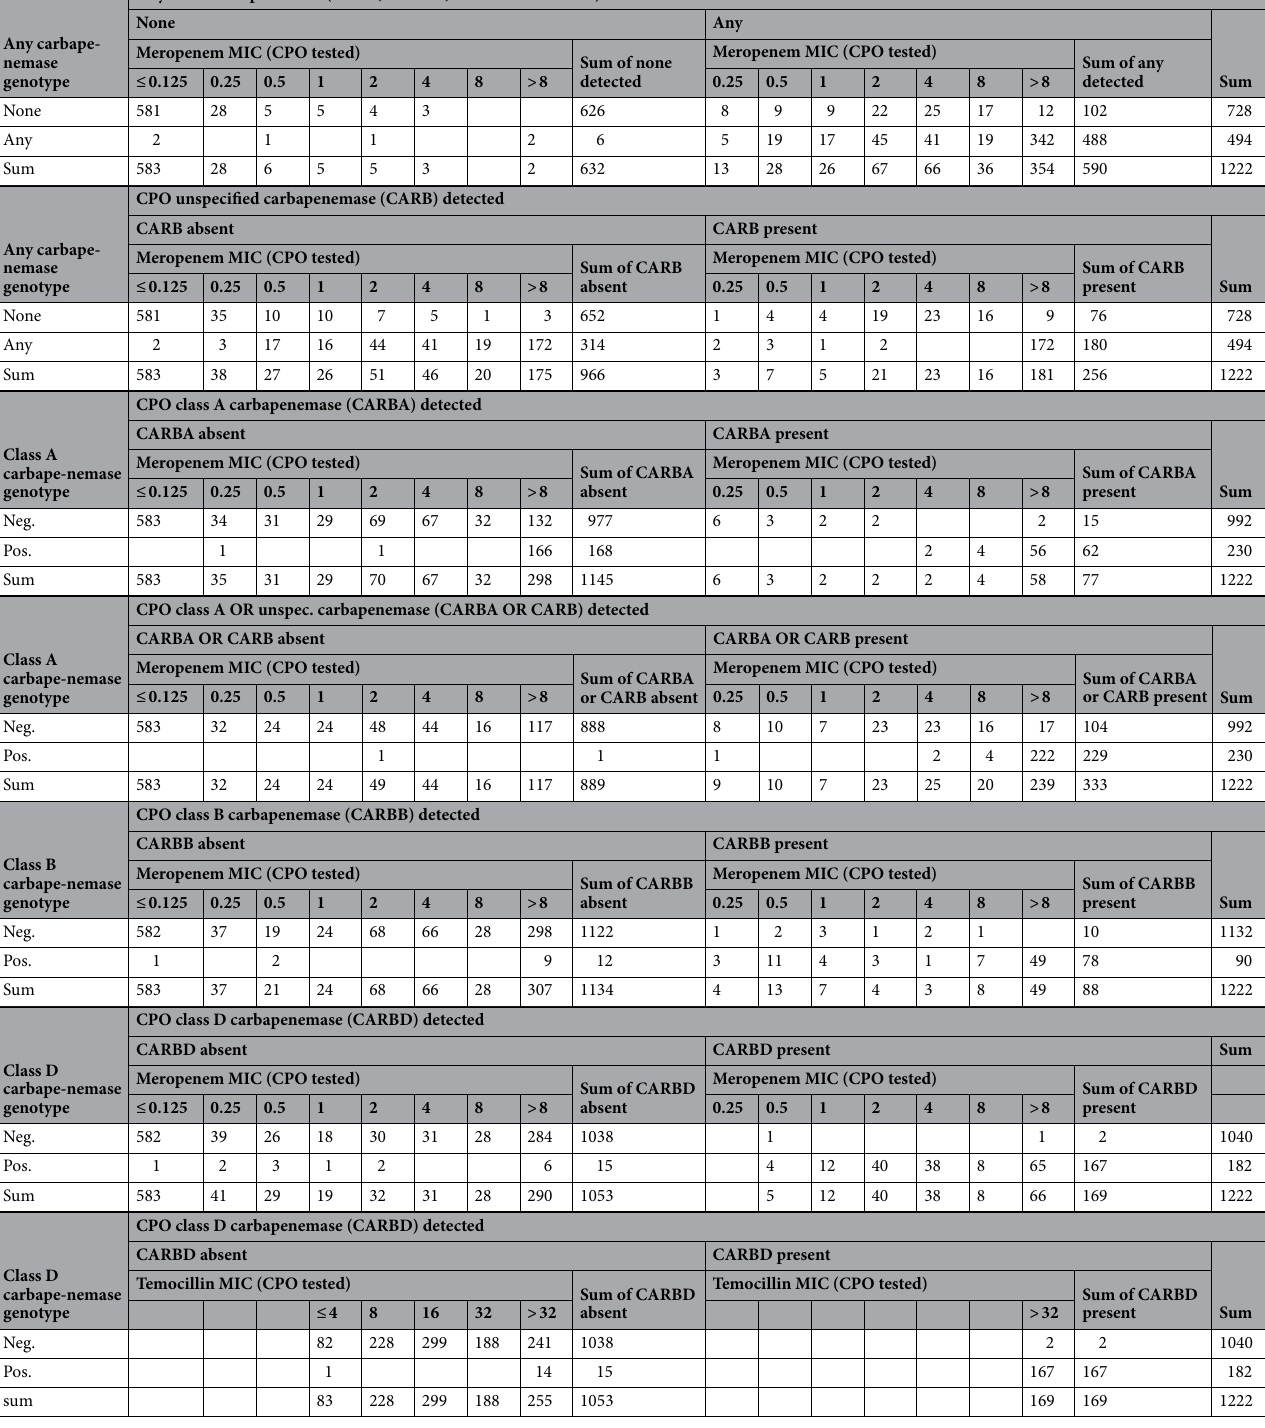
Table 2. MIC distribution and CPO panel detection of (un-)classified carbapenemase phenotypes (columns) in genotyped strains